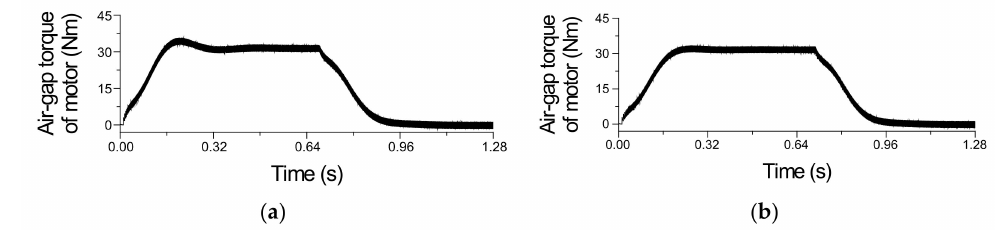
Figure 11. The waveforms of the air-gap torque of an induction motor in the control system shown in Figure 7 with a linear ( a ) and non-linear ( b ) torque limit controller during motor start-up.